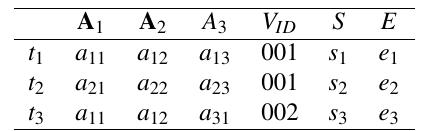
Table 11. Sample database containing the instance r of the fuzzy valid-time relation R FTG